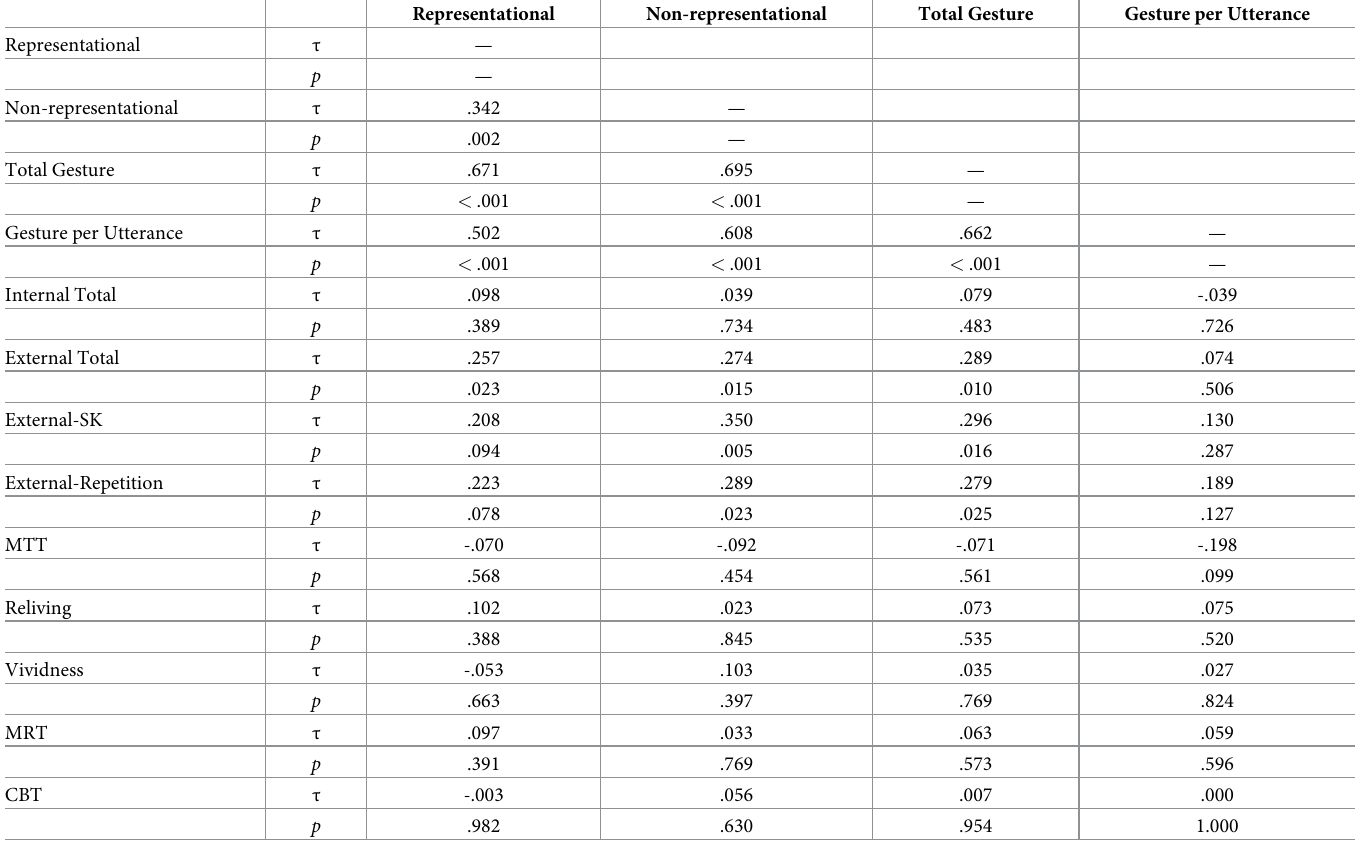
Table 3. Correlation matrix for future